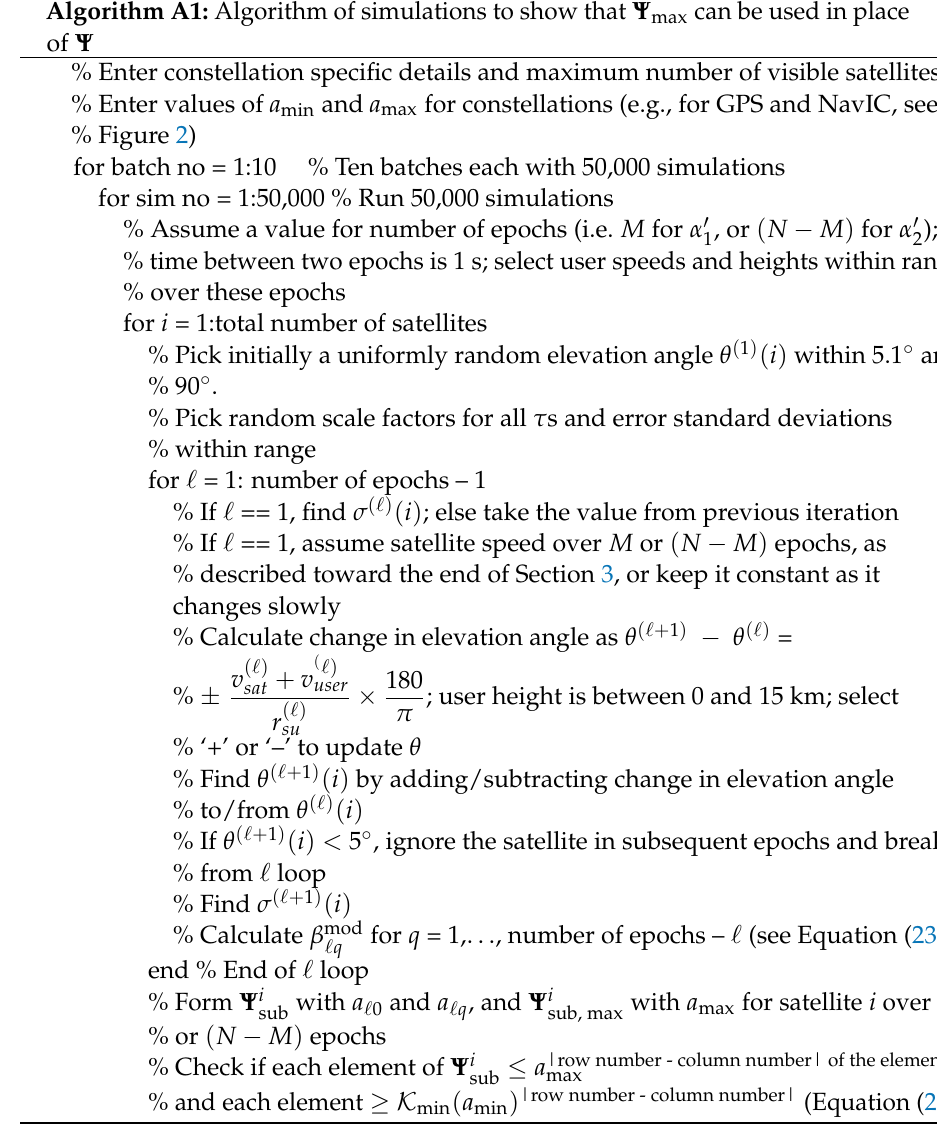
Algorithm A1: Algorithm of simulations to show that Ψ max can be used in